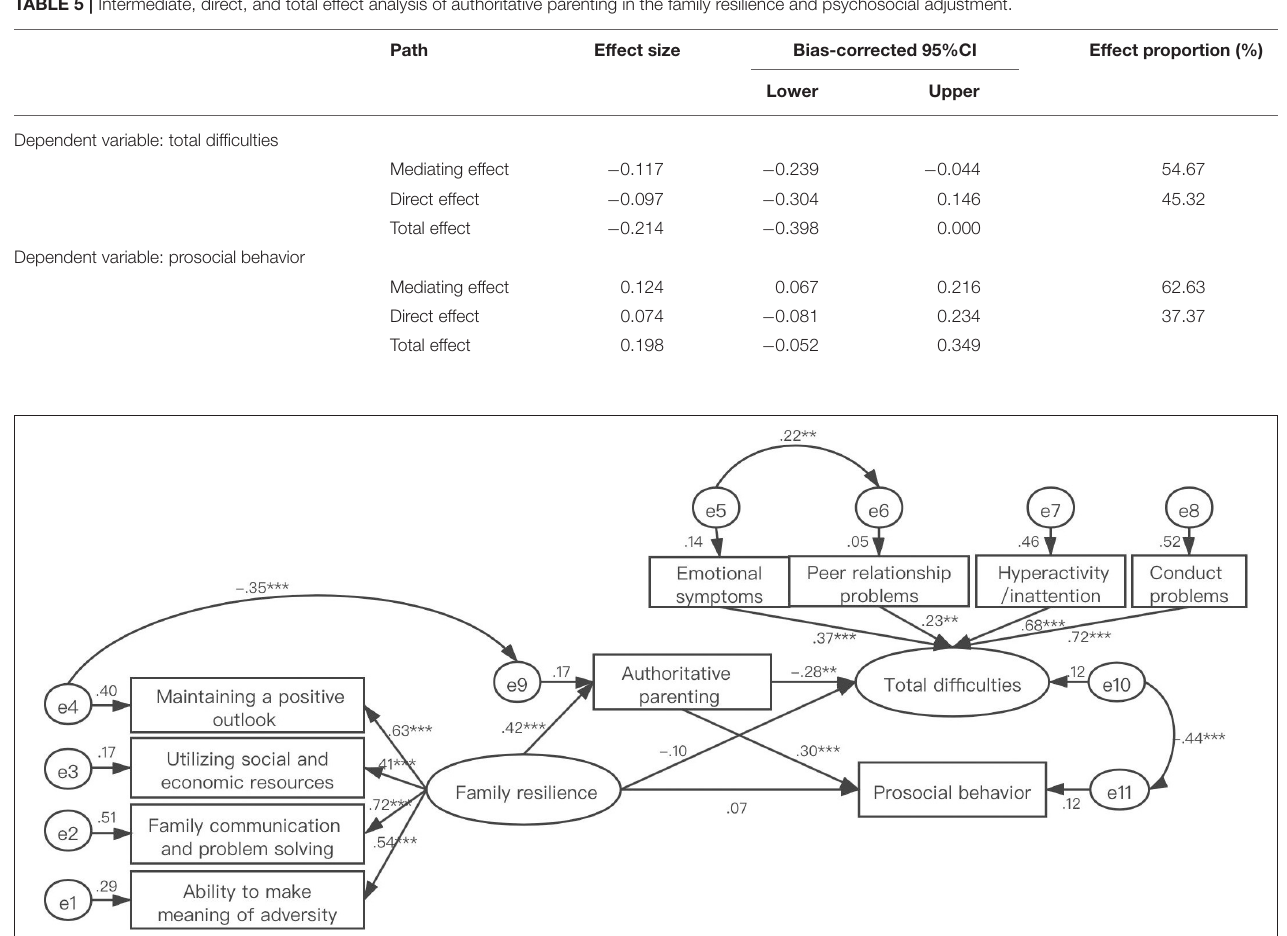
TABLE 5 | Intermediate, direct, and total effect analysis of authoritative parenting in the family resilience and psychosocial adjustment.